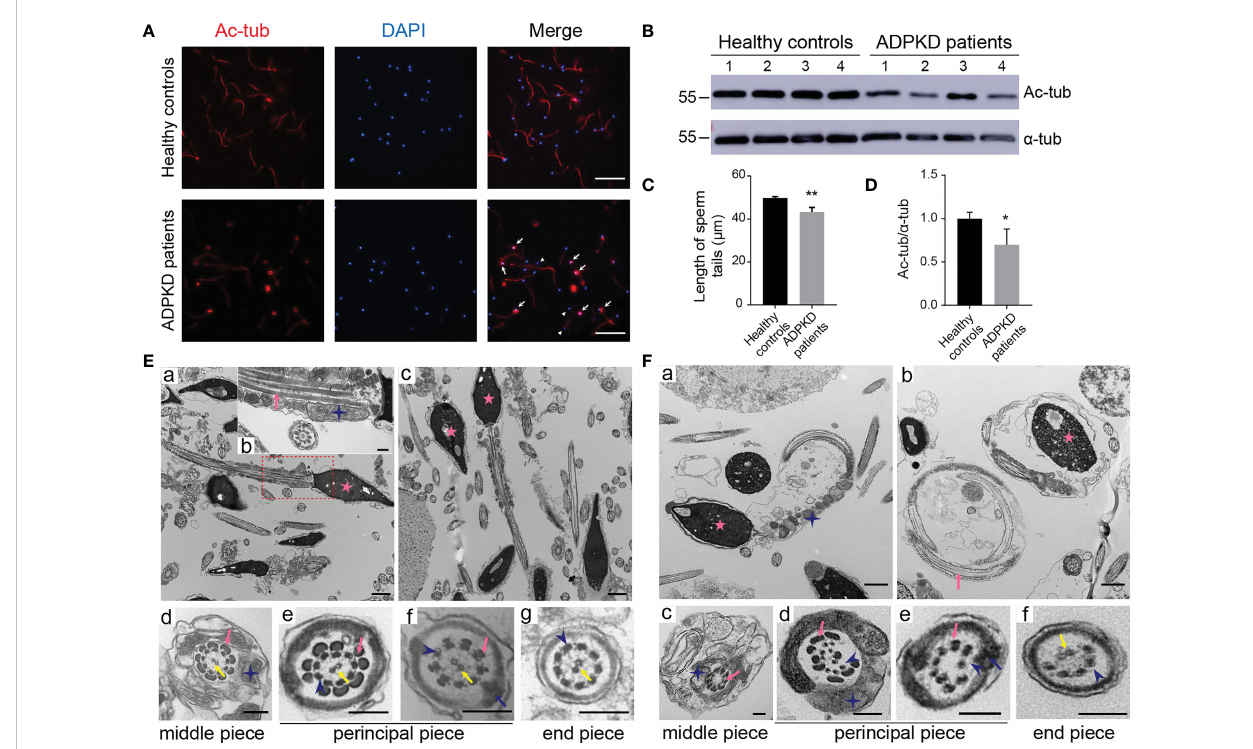
FIGURE 1 Morphology of sperm from healthy controls and ADPKD patients. (A) Immuno fl uorescence staining of sperms. White arrows indicate curled sperm fl agella stained with acetylated a -tubulin (red signal) in ADPKD patients. White arrowheads indicate small sperm heads stained with 4 ’ ,6-diamidino- 2-phenylindole (DAPI) (blue signal). Scale bar: 50 m m. (B) Representative western blotting images of acetylated a -tubulin and a -tubulin in sperms from healthy controls and ADPKD patients (n=4). (C) Comparison of sperm tail length between controls and ADPKD patients (n=4). At least 30 sperms were counted from each individual observed from three random fi elds per slide. (D) Relative intensities of acetylated a -tubulin/ a -tubulin in sperms. (E) Ultrastructure of sperm fl agella from healthy controls. (a, c) Longitudinal sections of normal spermatozoa with straight sperm tails. (b) Magni fi cation of the dotted area in (a). (d-g) Cross-sections of spermatozoa at various levels with regular arrangement of axonemes. (F) Ultrastructure of sperm fl agella from ADPKD patients. (a, b) Sperm fl agella in ADPKD patients are coiled and wrapped around the heads. (c-f) Disruption of axonemes or outer dense fi bers in the cross-section of sperm tails. Blue stars indicate mitochondria, pink arrows indicate outer dense fi bers, blue arrows indicate fi brous sheath, yellow arrows indicate central axoneme; blue arrowheads indicate peripheral axonemes, and pink stars indicate nuclei. Scale bars: Ea, Ec, Fa, Fb: 1 m m; Eb, Ed-g, Fc-f: 200nm. Error bars indicate standard deviation of three independent experiments (*P < 0.05, **P < 0.01; Student ’ s t